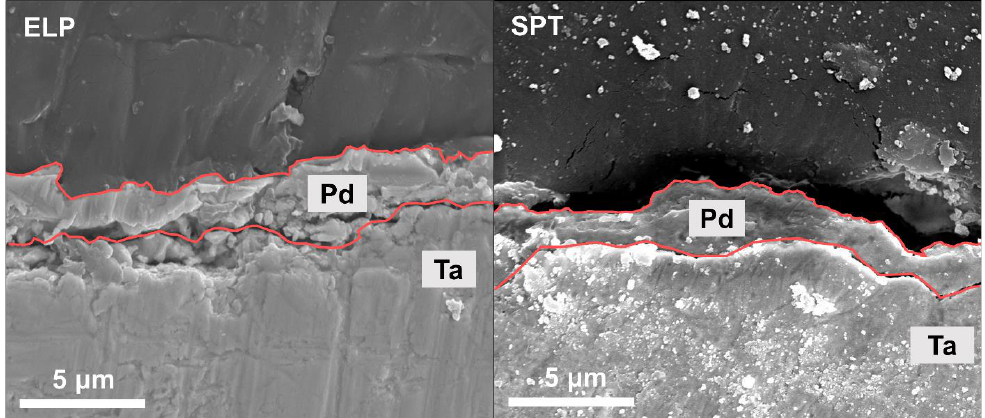
Figure 4. Cross-section SEM image of ELP and SPT Pd/Ta H 2 separation membrane after the perme- ation test at 500 °C; Red lines mark the interfaces of Pd layer with Ta support and resin embedding.